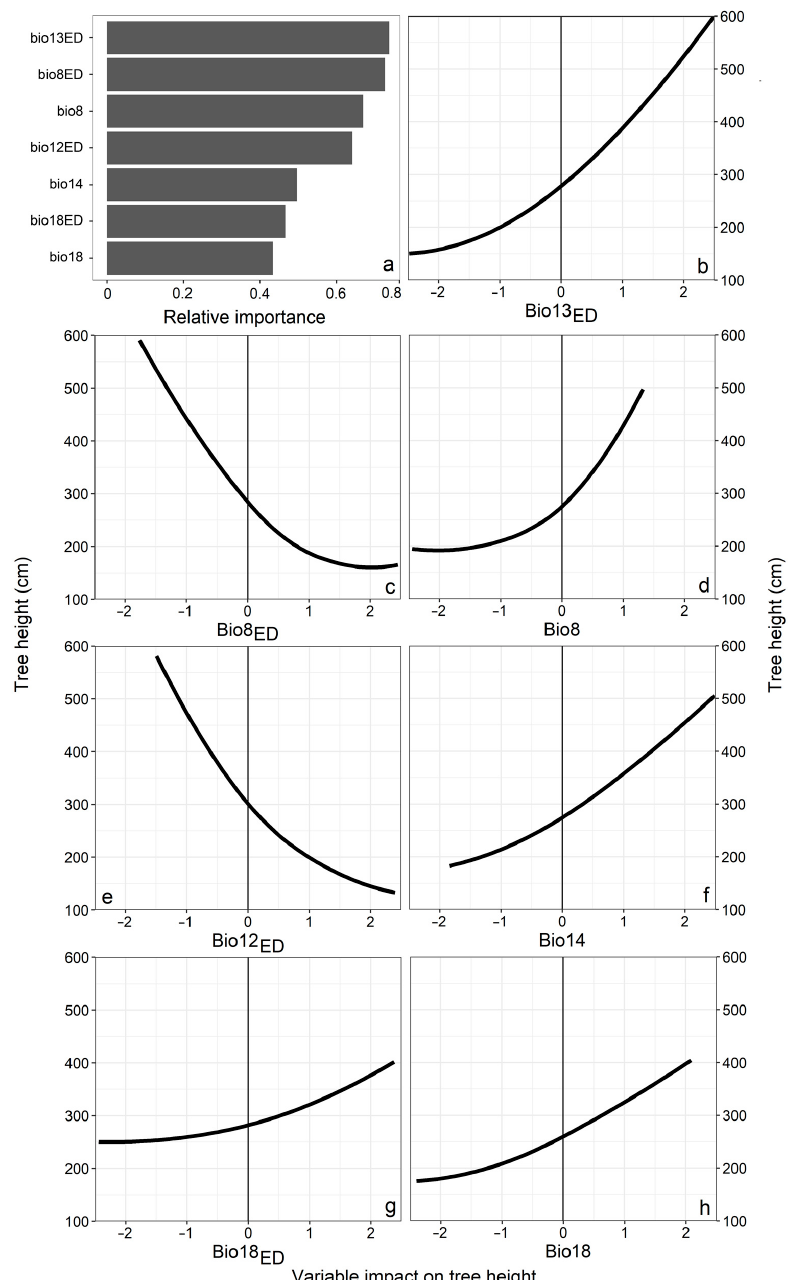
Figure 4. Sensitivity analysis of standardised variables within the neural network model ( a ), Bio13 = precipitation of wettest month ( b ), Bio8 = mean temperature of wettest quarter ( c , d ), Bio12 = annual precipitation ( e ), Bio14 = precipitation of driest month ( f ), Bio18 = precipitation of warmest quarter ( g , h ). Bio variables with ED subscript represent the ecodistance, which is the difference between the climate at the site of origin and the climate of new sites.